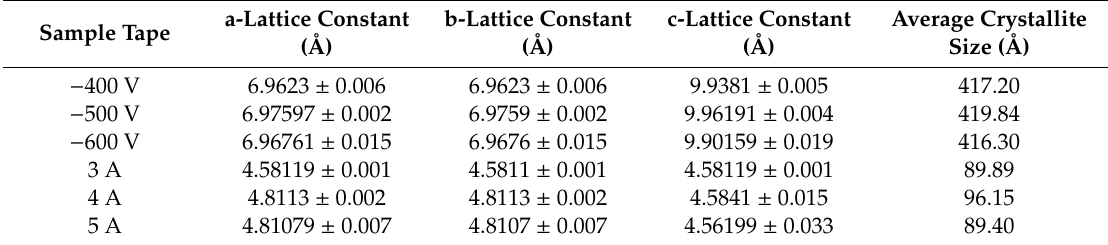
Table 2. Lattice parameters and average crystallite size for the plasma-nitrided coating and CrN x coating under different condition grains (as extracted by Rietveld whole pattern fitting).